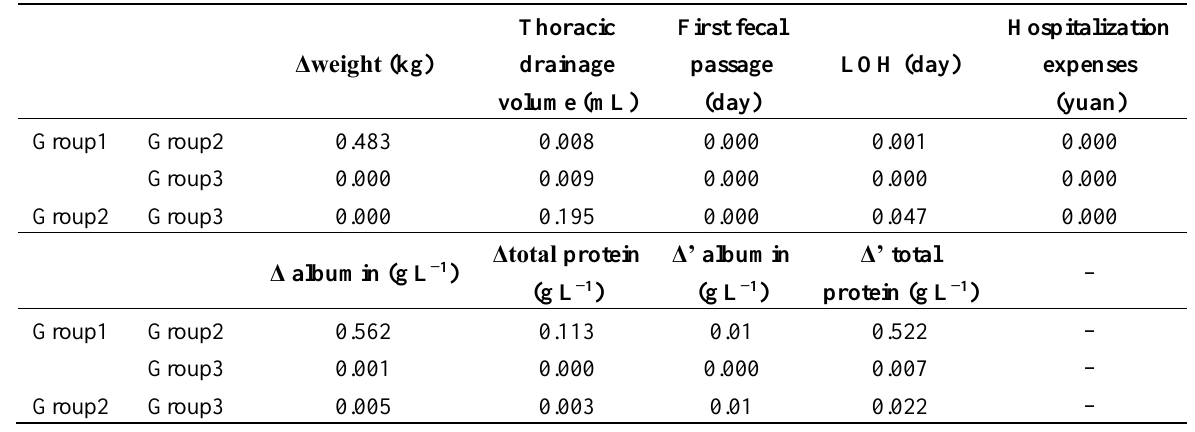
Table 5. The results of the multiple comparison ( p